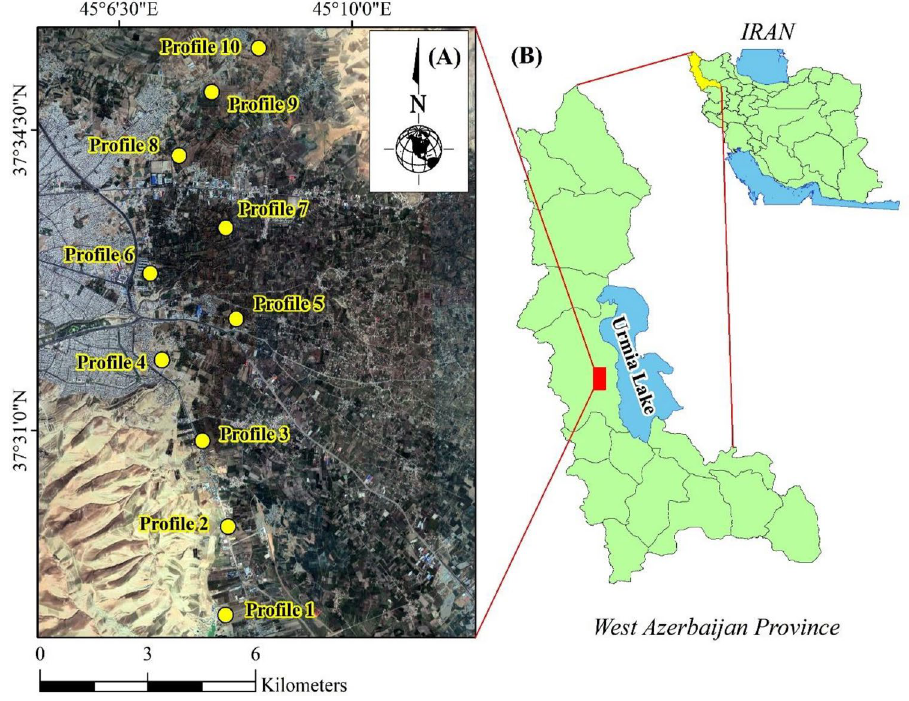
Figure 1. The location of the study area (https:// www. qgis. org/ and https:// www. google. com/